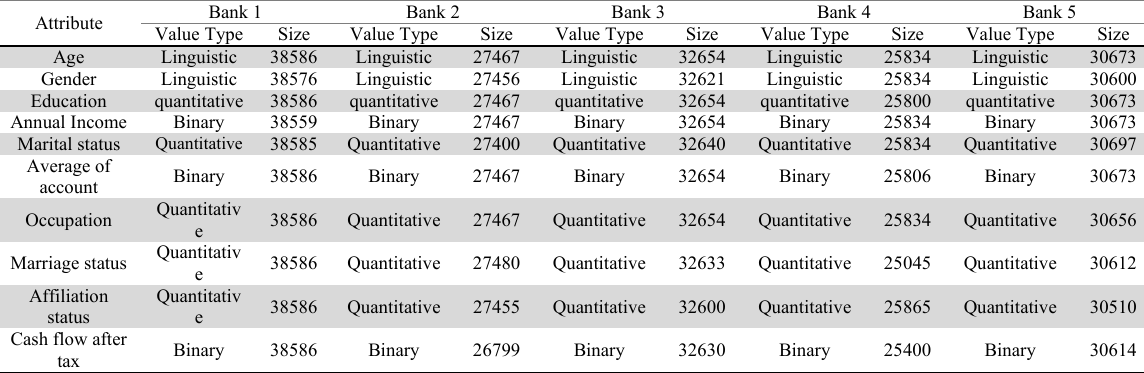
Characteristics of data set of five bank considered.